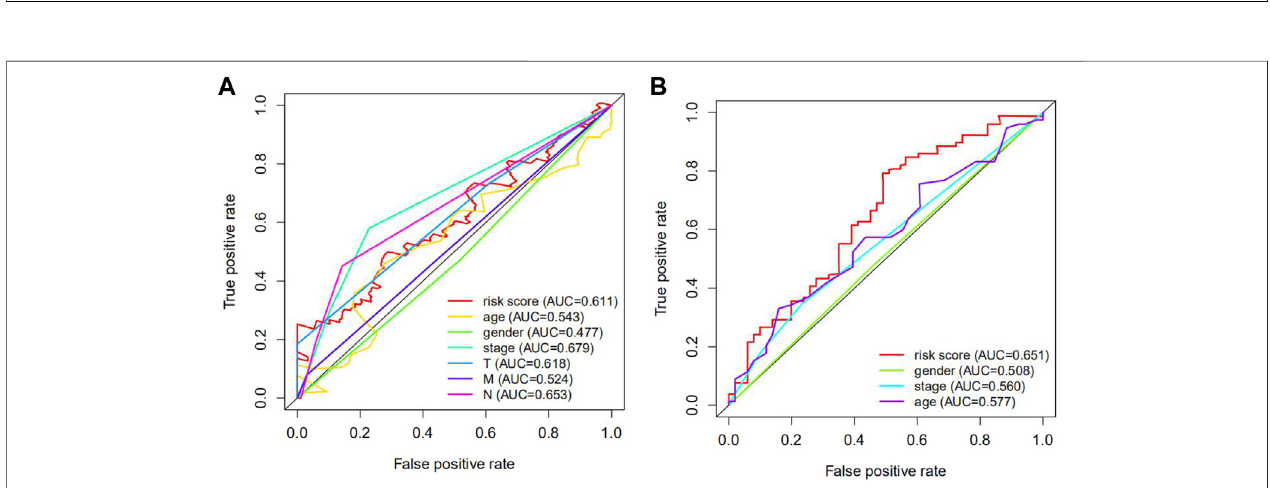
FIGURE6| Thereceiveroperatingcharacteristic(ROC) curveofTCGAandGEOcohorts. (A) theROCcurveofTCGAcohorts. (B) theROCcurveofGEOcohorts. The AUC of the ROC curve was more than 0.5, which signi fi ed that the predictive model possessed extraordinary diagnosis and prediction values.